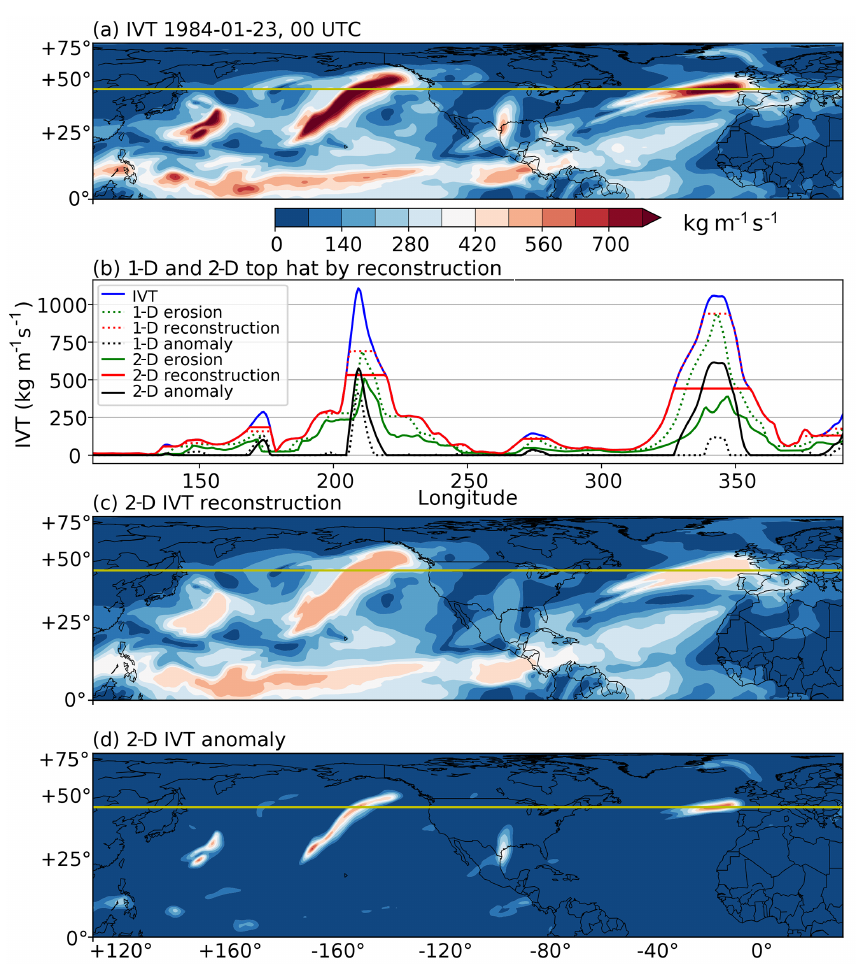
Figure 1. Illustration of 1-D and 2-D THR processes. (a) Snapshot of IVT in kgm − 1 s − 1 on 23 January 1984 at 00:00UTC. The horizontal line denotes a zonal cross-section. (b) IVT profile along the zonal cross-section defined in panel (a) as a blue curve. Green curves are profiles of erosion, red ones the reconstructions, and black ones the anomalies. Dashed lines show results obtained via 1-D erosion/reconstruction and solid lines are results from 2-D versions. (c) A 2-D reconstruction of IVT, in kgm − 1 s − 1 . (d) IVT anomaly defined as the difference between IVT and 2-D reconstruction, in kgm − 1 s − 1